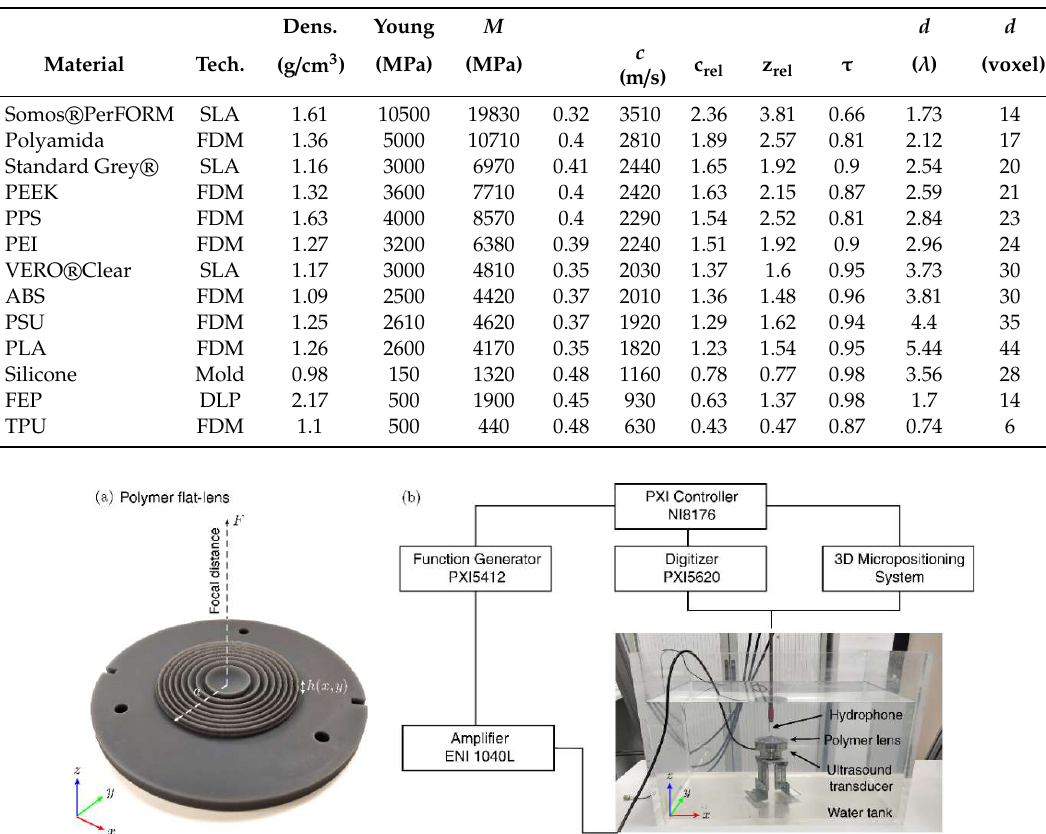
Figure 2. ( a ) Photograph of the flat-lens manufactured by a stereolithographic 3D-printing technique using a photopolymer. ( b ) Scheme of the setup and equipment used for the experiments in water tank.